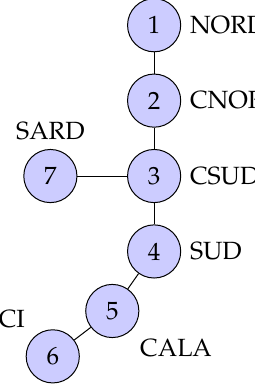
Figure 1. Electricity market zones in